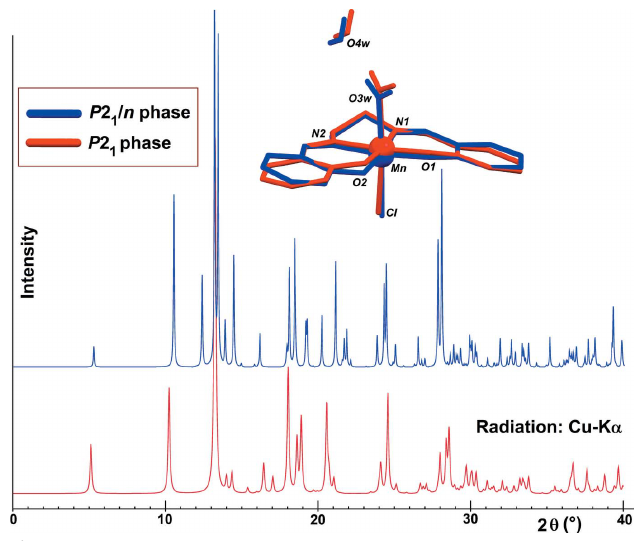
Figure 2 Simulated powder diffraction patterns for the P 2 1 / n form of the title compound (Panja et al. , 2003; blue spectrum) and the P 2 1 form (this work; red spectrum). A fit between the molecules constituting the asymmetric units in both phases is also displayed, using the same colour scheme (Macrae et al. ,